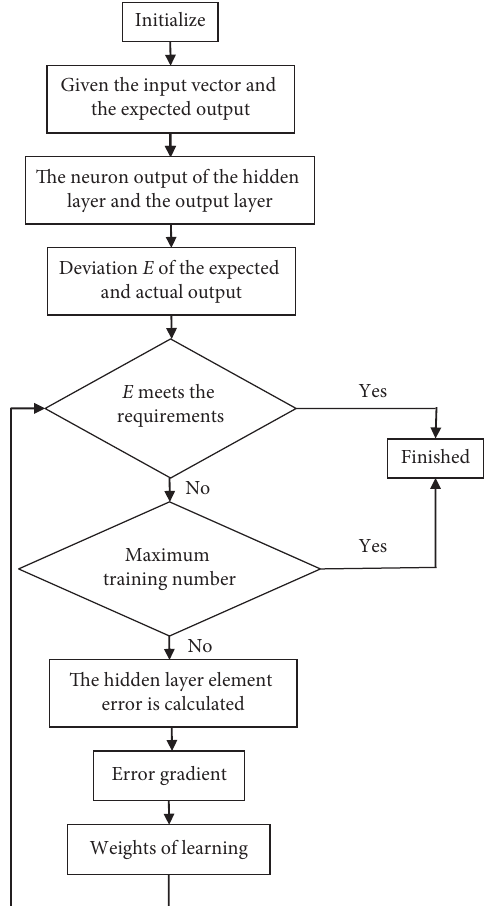
Figure 2: BP neural network flow chart.